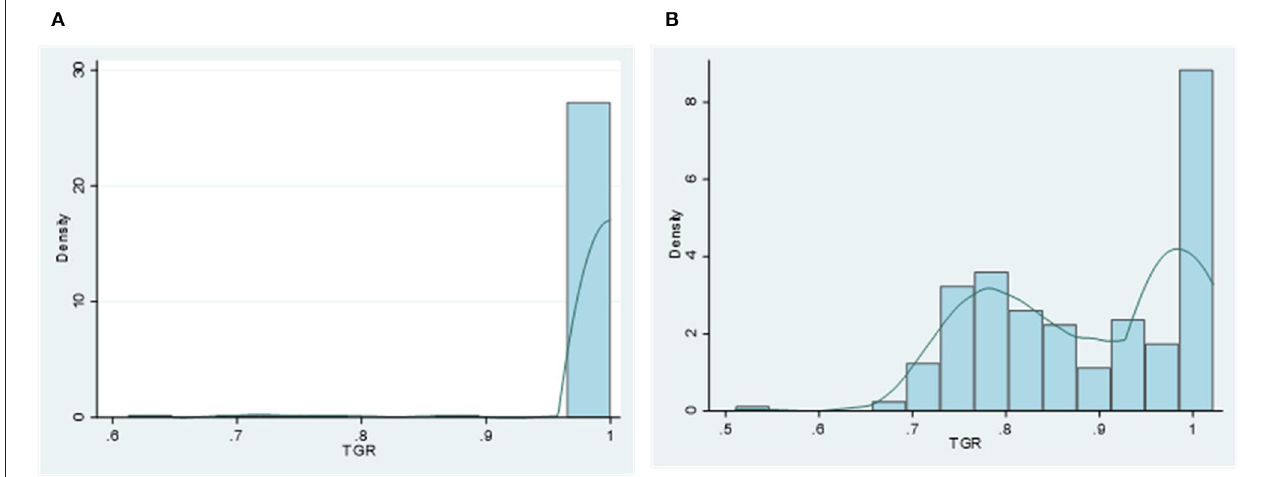
FIGURE 2 | Histogram and kernel density estimation of each region’s technical gap ratio (TGR). (A) Eastern region. (B) Non-eastern region.